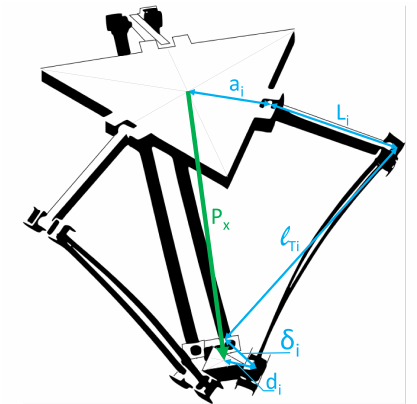
Figure 9. Graphical representation of the loop closure of a Delta Robot.